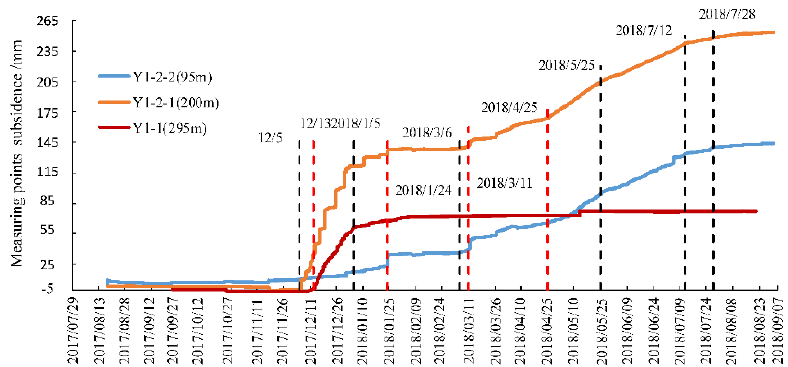
Figure 14. The rock movement in the borehole above goaf at 207 working face.